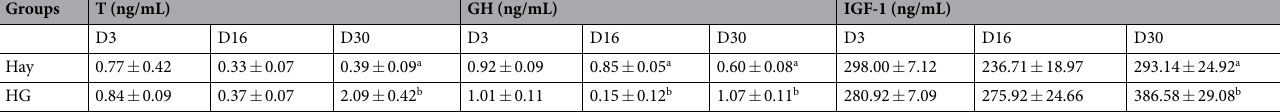
Table 1. Hormone levels of hay and HG groups. a,b,c Different letters denote statistically significant differences within each hormone ( p < 0.05).